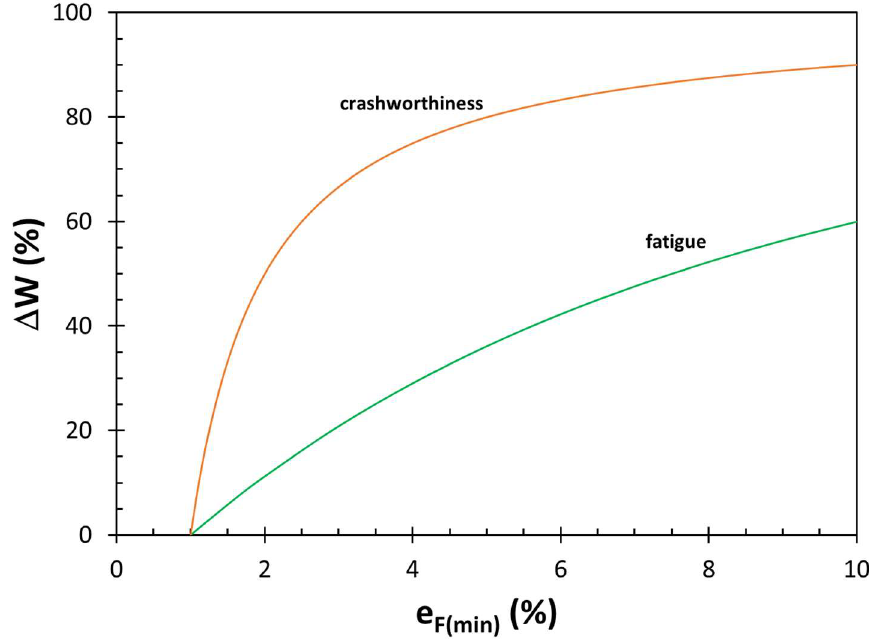
Figure 5. Weight reduction potential (%) as a function of increase in minimum elongation requirement for crashworthiness and fatigue performance. Fatigue is the limiting factor in this case.